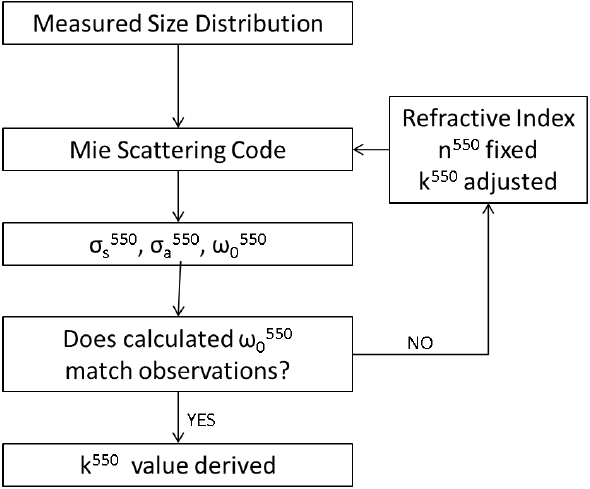
Fig. 4. Flow chart showing iteration process for deriving k 550 for Figure 4 the accumulation mode. n 550 is assumed to be 1.53. Input size dis- tribution is adjusted for losses and enhancements due to Rosemount inlets and pipe